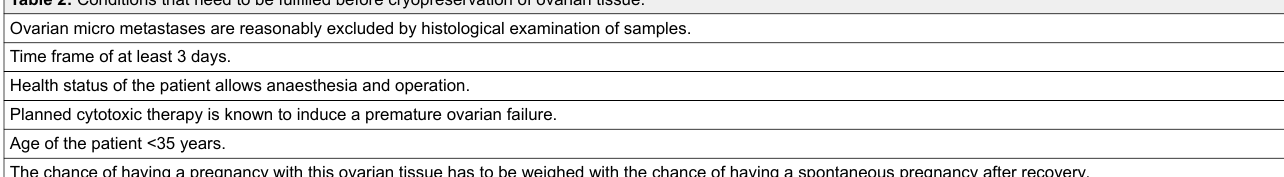
Table 2: Conditions that need to be fulfilled before cryopreservation of ovarian tissue. Ovarian micro metastases are reasonably excluded by histological examination of samples. Time frame of at least 3 days. Health status of the patient allows anaesthesia and operation. Planned cytotoxic therapy is known to induce a premature ovarian failure. Age of the patient <35